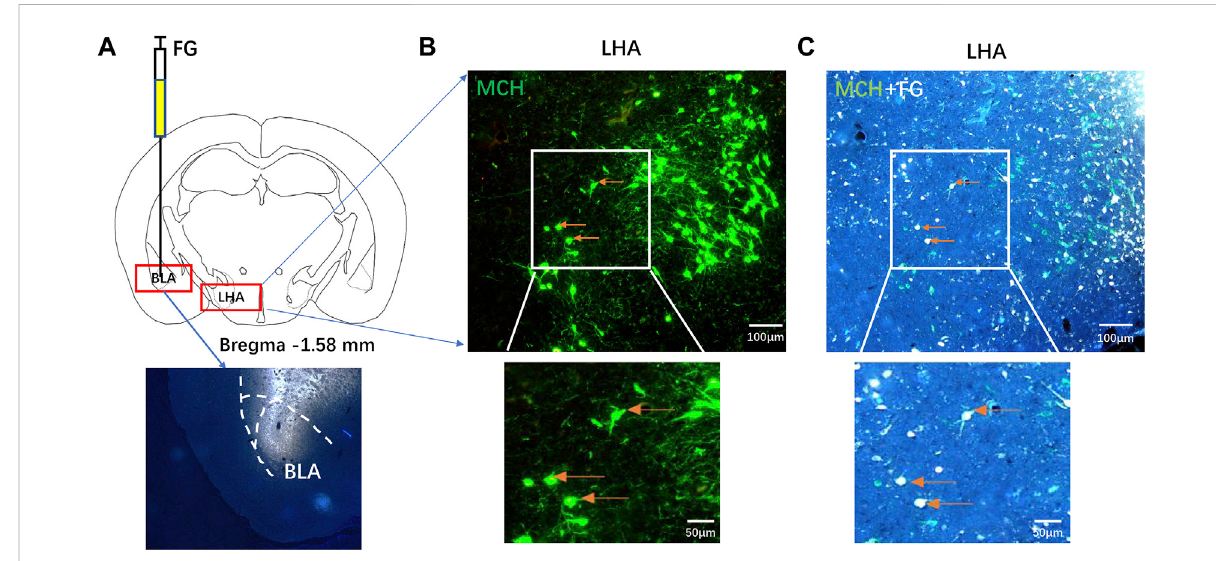
FIGURE 2 MCH-immunoreactive neurons in the LHA projected to the BLA. (A) A schematic diagram and injection site of FG microinjection into the BLA. (B,C) After seven days of FG retrograde tracking, the fl uorescence immunohistochemistry showed that the MCH neurons in the LHA (B) and the MCH/FG co-expressing neurons extend from the BLA into the LHA (C) ( n =